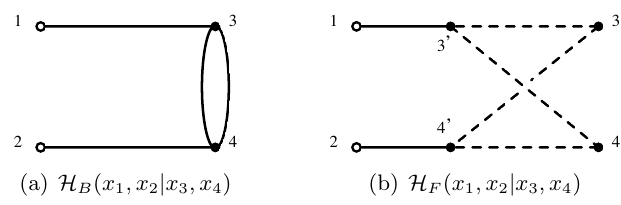
Figure 11 . The kernels associated to the Hamiltonian graph-building operators ^ H B and ^ H F involved in the computation of the four-point function G (cid:30) external points and black dots integration over the full space R 4